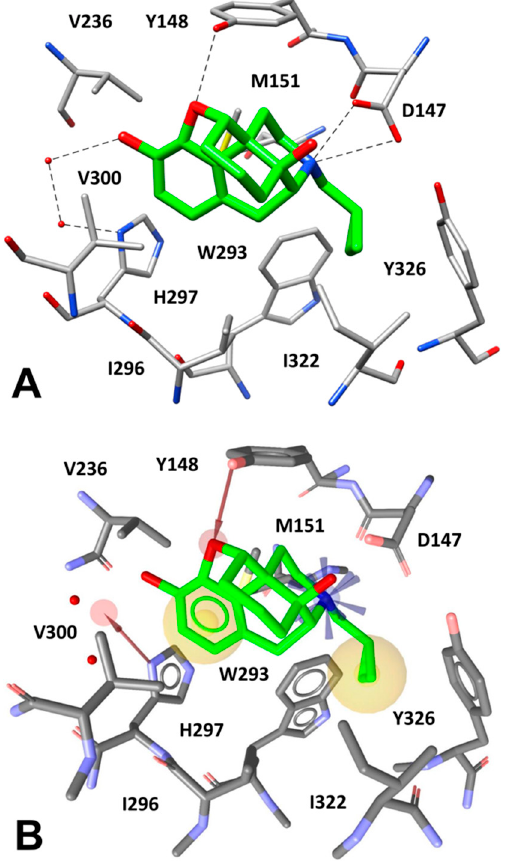
Figure 3. ( A ) Interactions of β -FNA core scaffold (green) inside MOR binding site (gray) and ( B ) receptor-based pharmacophore model used for the VS study, superimposed to the complex.